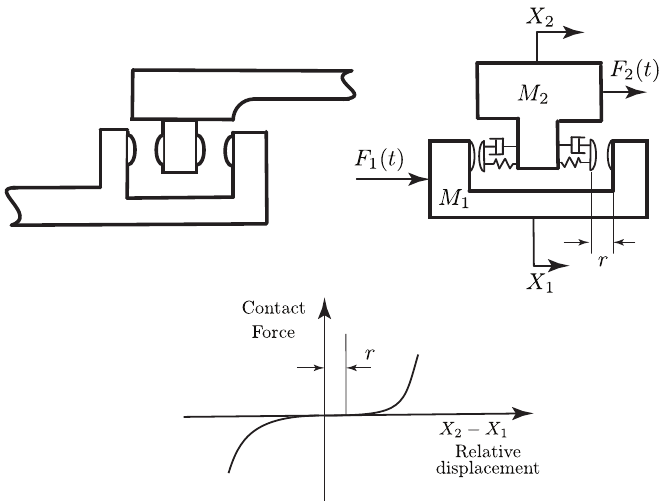
Figure 1. Dubowsky and Freudenstein elastic coupling model. F 1 , F 2 : Forces; M 1 , M 2 : Masses; X 1 , X 2 : Displacements; r : clearance [33].